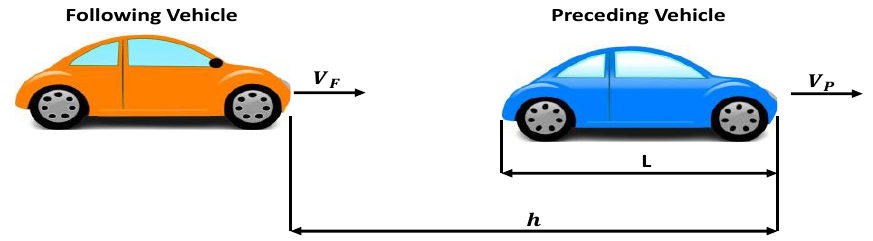
Figure 2. Overview of TTC Algorithm [18] .